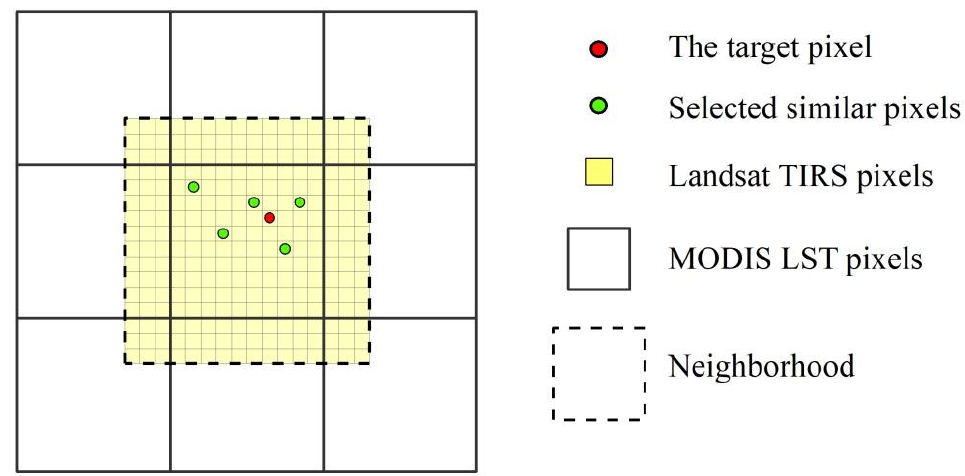
Figure 3. Schematic diagram of similar pixels selected in a neighborhood range of the target pixel. ∆ F ( x ij , y ij , LST) depends on the changes in MODIS LSTs from t b to t p , which can be estimated using the distributed residual r and temporal change information ∆ F :